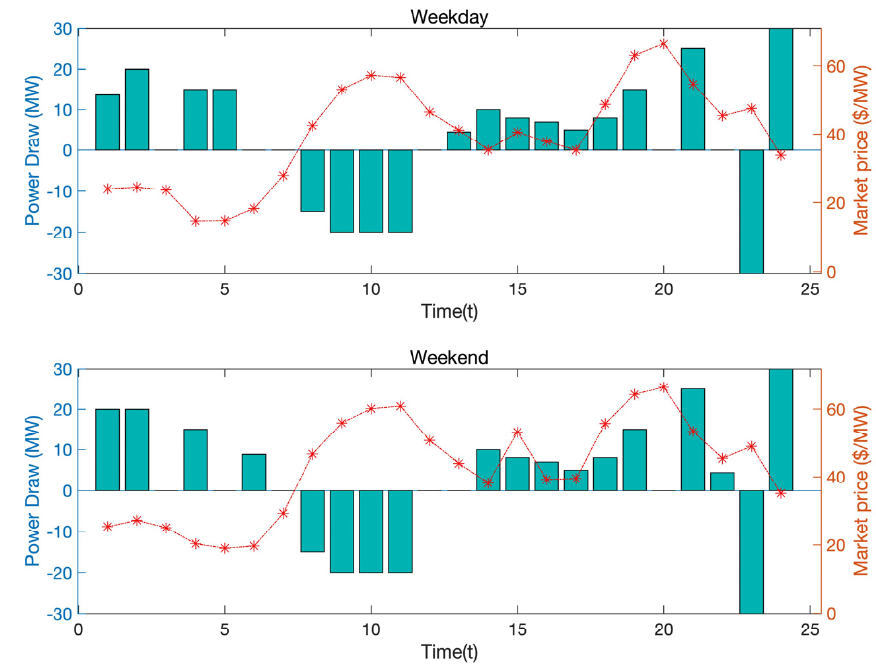
Figure 6. Comparison of preferred operating point of Audi e-tron.